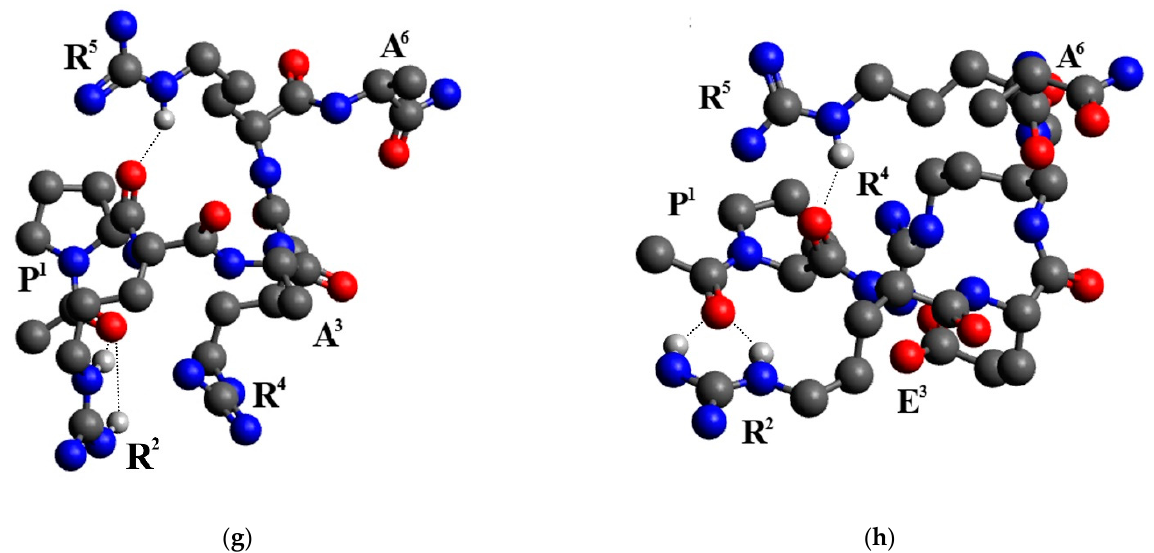
Figure 5. The lowest energy conformations of the peptides obtained at the dielectric constant, ε = 10. The carboxyl groups of the glutamic acid side chains were considered deprotonated and negatively charged, except for Ac-RER-NH 2 , which was considered neutral. Carbon atoms—gray spheres; oxygen atoms—red spheres; nitrogen atoms—blue spheres. Hydrogen atoms (white spheres) are not shown for clarity unless involved in highlighted hydrogen bonds. Hydrogen bonds between the proline residue and guanidinium groups of the arginine side chains in the Ac-PRARRA-NH 2 and Ac-PRERRA-NH 2 molecules are presented with dotted lines. The amino acid residues are enumerated. Ac-RAR-NH 2 ( a ), Ac-RAAR-NH 2 ( b ), Ac-REAR-NH 2 ( c ), Ac-REAAR-NH 2 ( d ), Ac-RER- NH 2 ( e ), Ac-RERR-NH 2 ( f ), Ac-PRARRA-NH 2 ( g ), and Ac-PRERRA-NH 2 ( h ).